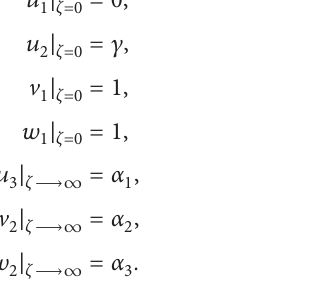
variation on θ ( ζ ) 1